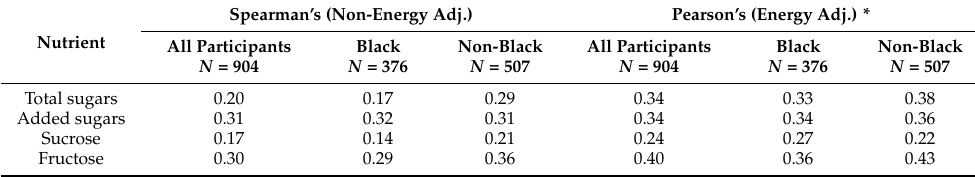
Table 4. Correlations of nutrient intake for FFQ and 24-h recall.